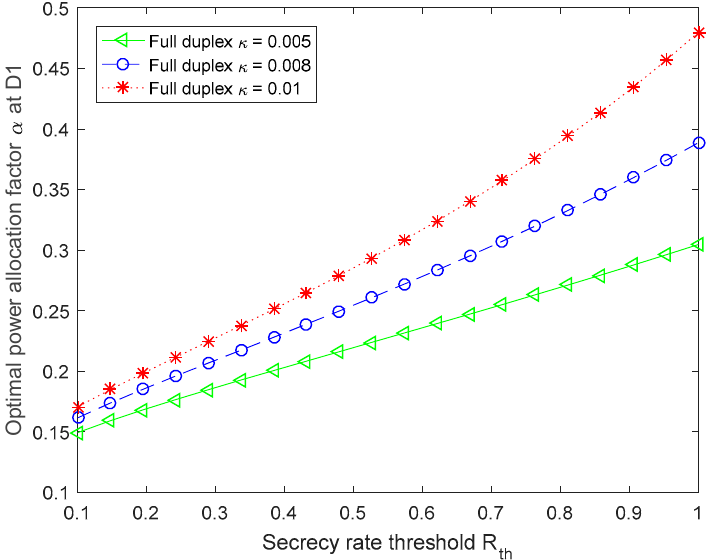
Figure 3. The optimal power allocation factor at D1 versus secrecy rate threshold.